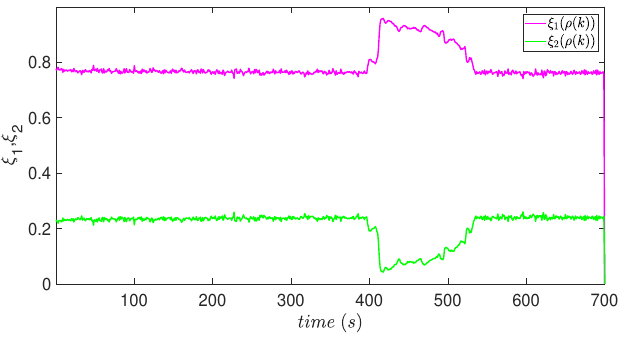
Figure 7. Membership functions.